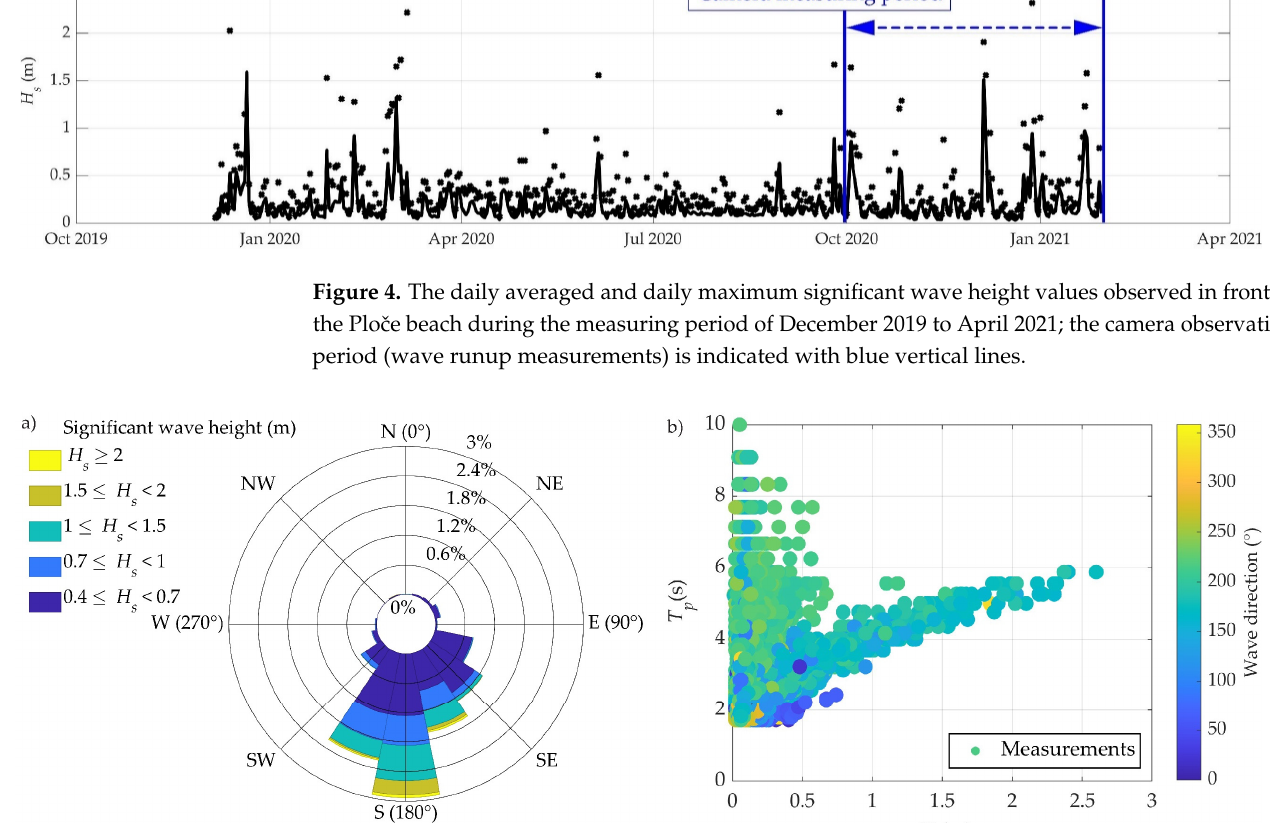
Figure 5. ( a ) The wave rose for the wave buoy during the measuring period (December 2019 to April 2021) in front of the Plo č e beach; ( b ) scatter plot of significant wave heights against peak wave pe- riods during the measuring period with wave direction as coloring. Hourly tidal data are obtained from the nearby tidal gauge station, Bakar, at the northern tip of Bakar Bay (45 ◦ 18.3 (cid:48) N, 14 ◦ 32.4 (cid:48) E). The tides in the Adriatic Sea have